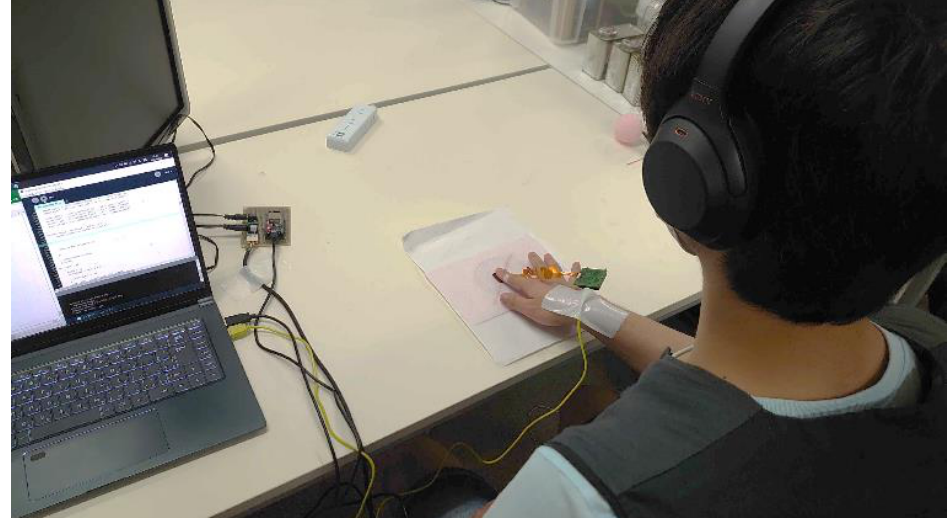
Figure 9. The experiment being performed by a subject.